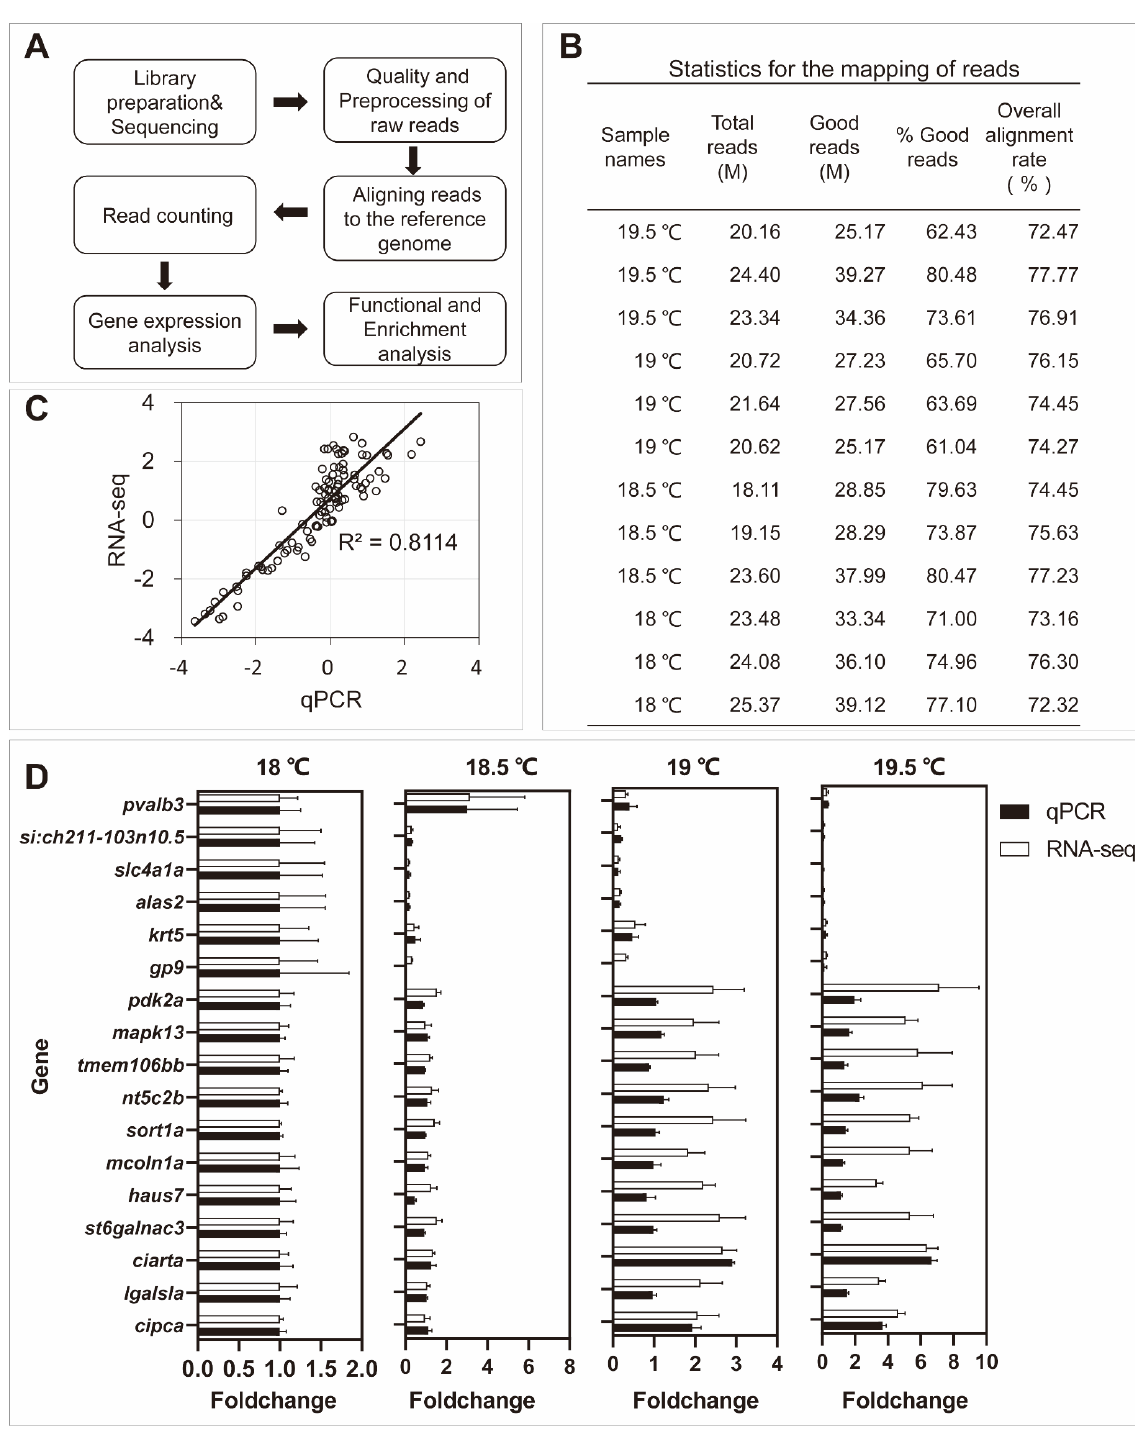
Figure 2. The workflow of RNA − seq data analysis. ( A ) Main steps of RNA − seq data analysis in the study. ( B ) Statistics for mapping of reads in four groups. The sample names used the experimental temperatures. Temperatures at 19.5 °C and 19 °C are egg − spawning groups and temperatures at 18.5 °C and 18 °C are non − spawning groups. ( C ) Validation of RNA − seq data with quantitative RT − PCR (qPCR). Log2 fold changes of RNA − seq data for gene expression were plotted against those of qPCR data. The reference straight line in black indicates the linear relationship between the results of RNA − seq and qPCR. ( p < 0.00001, correlation coefficient = 0.8114). ( D ) Fold changes and standard error of mean (SEM) for 17 selected genes of RNA − seq were validated with